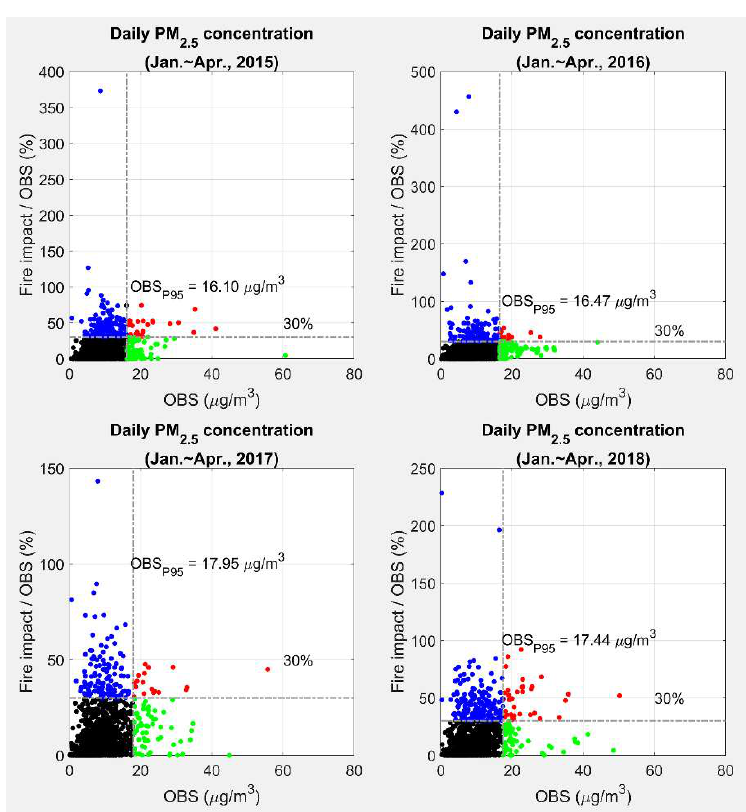
Figure 4. Relationship between daily total PM 2.5 observations (OBS) and ratios of observation-adjusted fire impact to OBS during January–April from 2015 to 2018. The number of points are listed in Table 3. Table 3. Number of points for each quadrant in Figure 4.